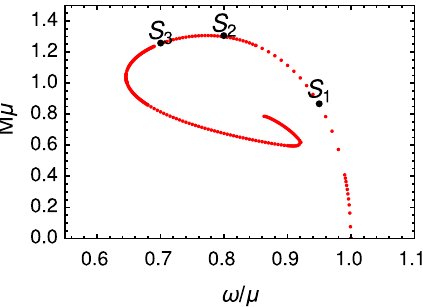
Fig. 4 Plots of the ADM mass M versus the frequency ω . Here we set the parameter k = 1 Table 1 Structures of circular orbits for a point-like test particle in the scalar boson star solutions S 1 , S 2 , and S 3 model